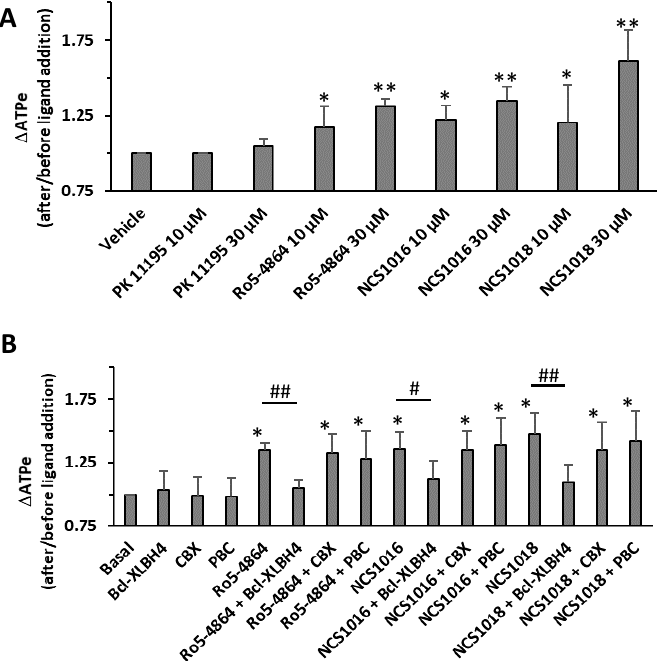
Figure 6. TSPO ligand-induced ATP release. ATP release from human red blood cells was measured at 37 ◦ C, 10% Hematocrit, as described in material and methods. Values are the ratio between extracellular ATP (ATPe) levels after and before the addition of TSPO ligands. Panel ( A ) shows the effect of 10 or 30 µ M of PK 11195, Ro5-4864, NCS1016, and NCS1018. Panel ( B ) shows the effect of VDAC inhibitor Bcl-XLBH4 (10 µ M), or Pannexin-1 inhibitors carbonexolone (CBX, 10 µ M), or probenecid (PBC, 10 µ M). Results are expressed as means ± SEM and considered different from basal (vehicle, unstimulated) values when * p < 0.05; ** p < 0.01 or from those incubated in the presence of Bcl-XLBH4 when # p < 0.05 and ## p < 0.01; N =